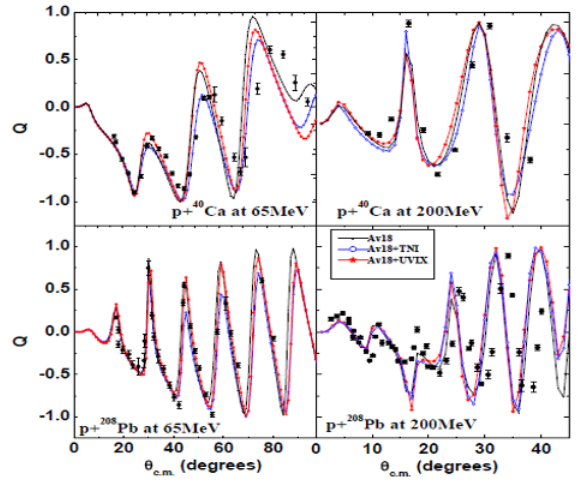
Figure 4: The spin rotation function (Q) for p - 40 Ca and p - 208 Pb